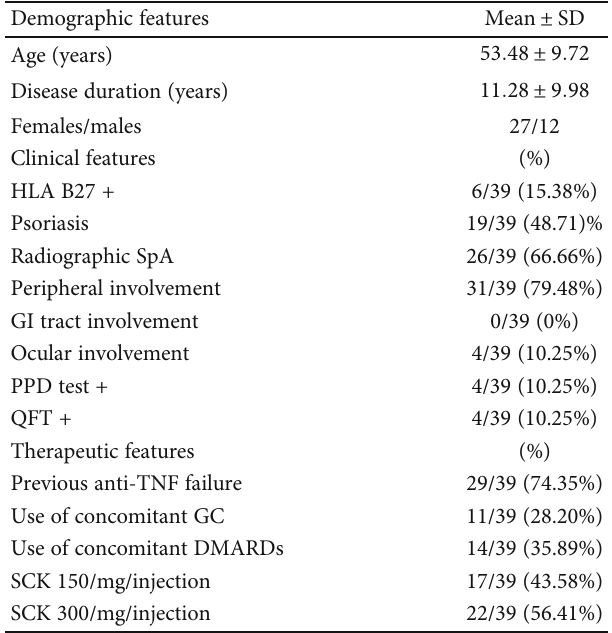
Table 1: Demographic and clinical data combined with therapeutic features of patients with axSpA enrolled in our